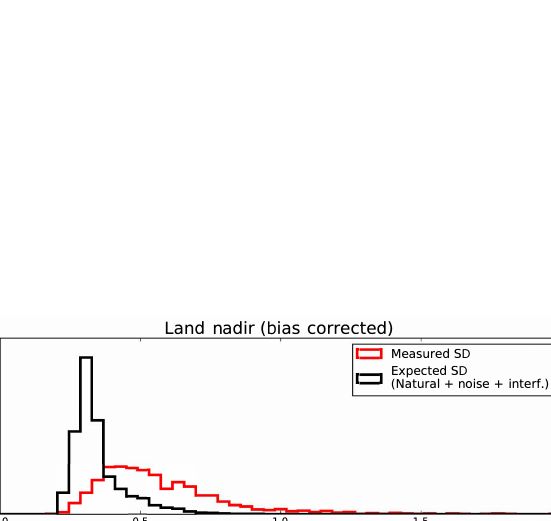
Figure A5. Same as Fig. A1 but for land-nadir scenes.